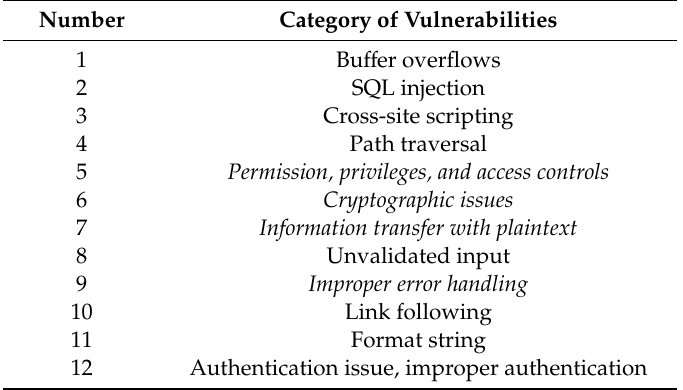
Table 11. Common categories of vulnerabilities in Common Vulnerabilities and Exposures (CVE), Open Web Application Security (OWAP). and National Vulnerability Database